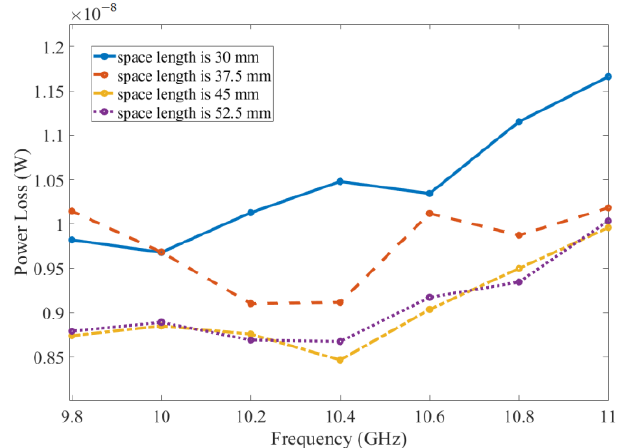
Figure 9. Power losses as a function of frequency under different space length. The period length of the array is twice the space length, which is the distance between the simulation boundary and the model.